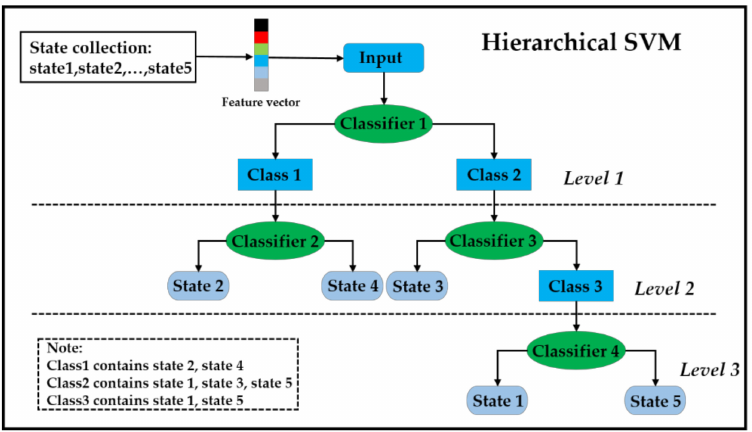
Figure 2. Schematic diagram of the structure of the h-SVM